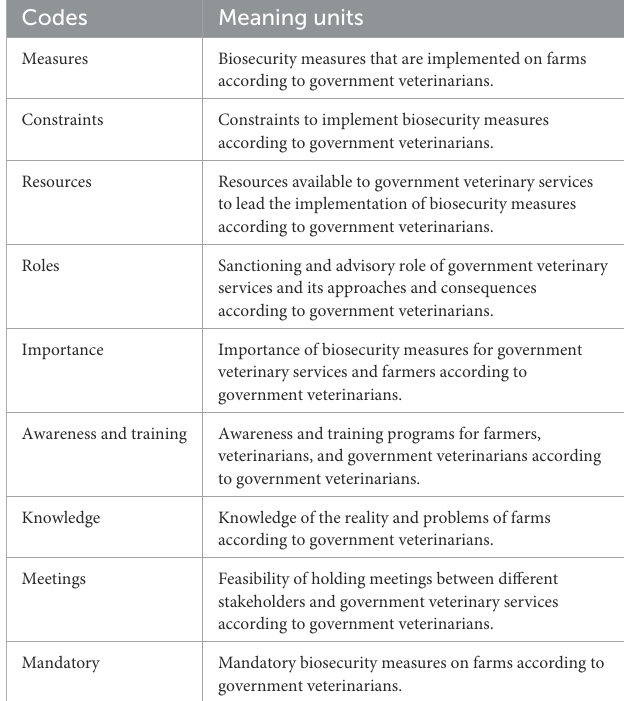
TABLE 1 Thematic guide on perceptions of government veterinary services in relation to biosecurity measures.